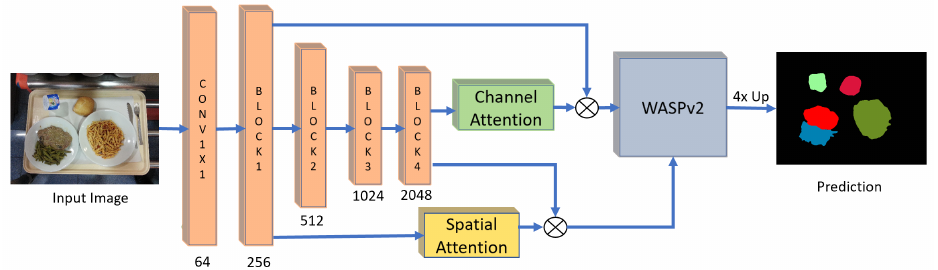
Figure 2. The proposed GourmetNet architecture for food segmentation. The input image is fed through a modified ResNet backbone and the features are refined by the spatial and channel attention modules before the multi-scale WASPv2 module which produces the output semantic segmentation result. The numbers below each block indicate the number of feature